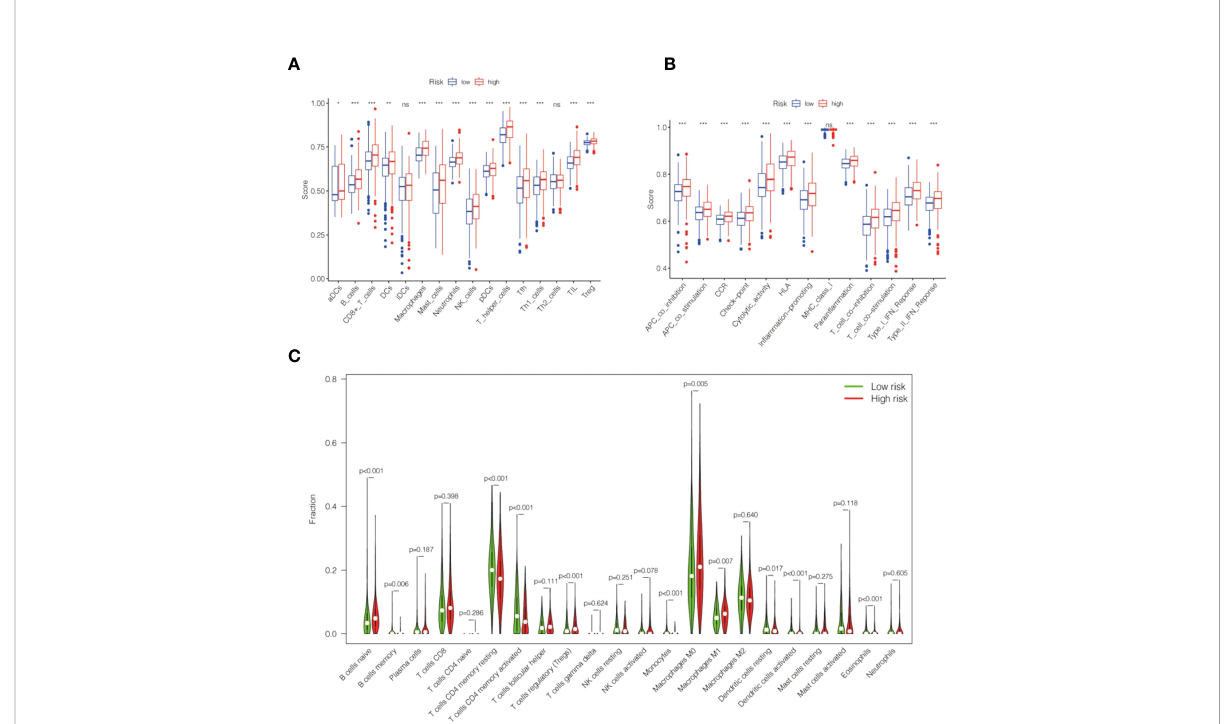
FIGURE 10 The correlation between the risk score of the cell senescence-related lncRNAs and tumor in fi ltrate. (A) Box plot revealing the relationship between immune cells and the risk score. (B) The box plot demonstrates the correlation between immune function and risk score. (C) Violin plot indicating the 22 tumor-in fi ltrating lymph cell distributions with different risk scores. *P<0.05, **P<0.01, ***P<0.001 and